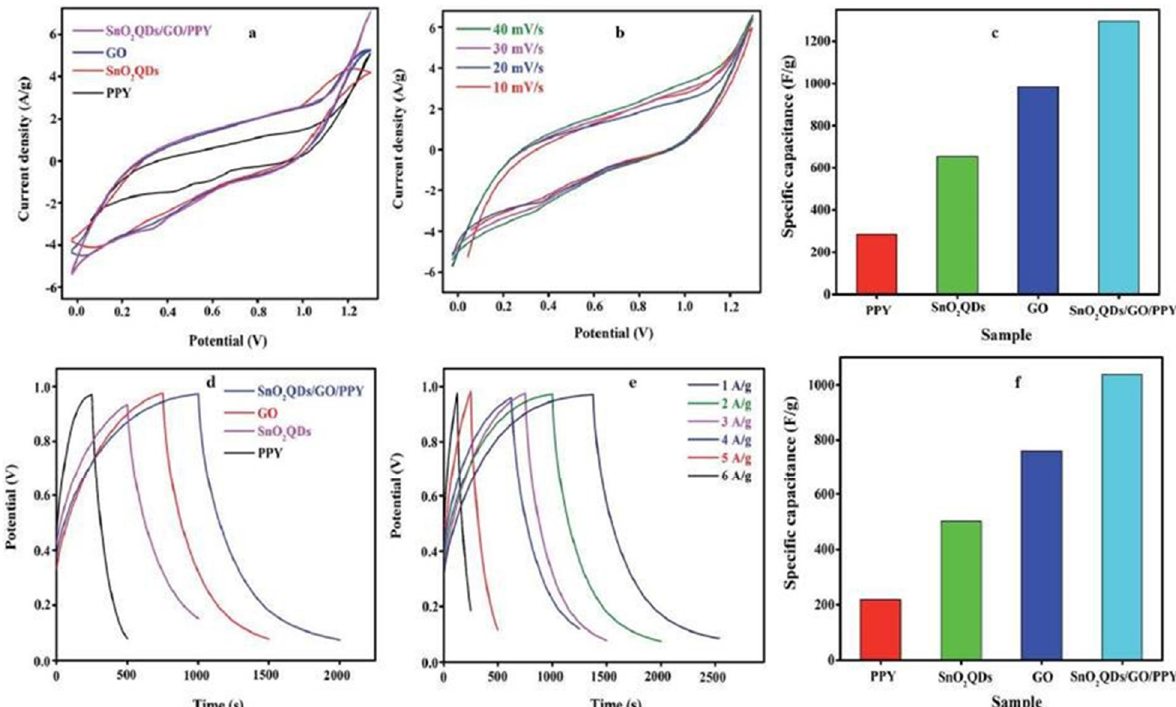
Figure 25. ( a ) CV curves of pure PPY, SnO 2 QDs, GO, and SnO 2 QDs/GO/PPY nanocomposites; ( b ) CV plot of SnO 2 QDs/GO/PPY nanocomposites; ( c ) cyclic voltammetry variation of Csp of various materials; ( d ) GCD of different nanocomposites; ( e ) GCD plots for SnO 2 QDs/GO/PPY ternary materials at different CD; ( f ) Csp of nanocomposites from GCD curve. Reproduced with permission from [105].